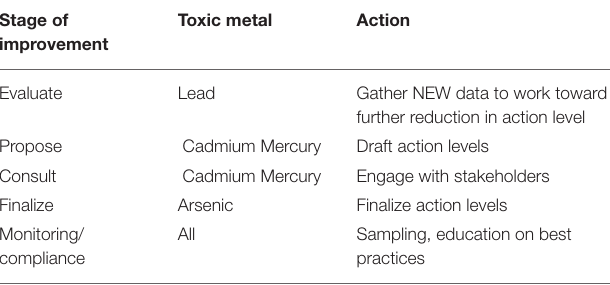
TABLE 8 | Phase 3 FDA’s Closer to Zero Action Plan: April 2024 – Beyond.